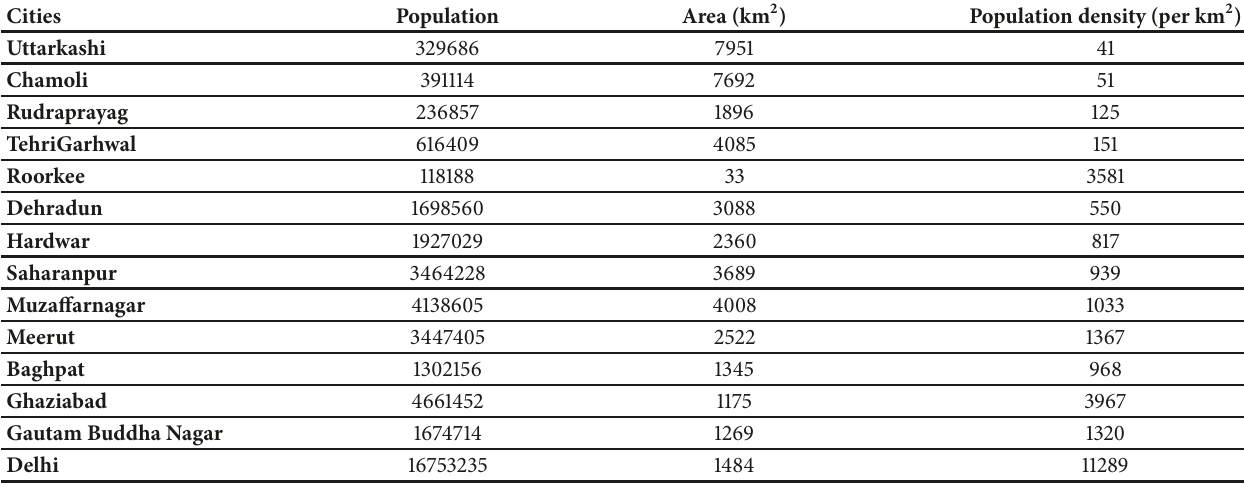
Table 2: List of cities included for EEW system instrumentation and for issuing warning with their population, area, and population density information according to census